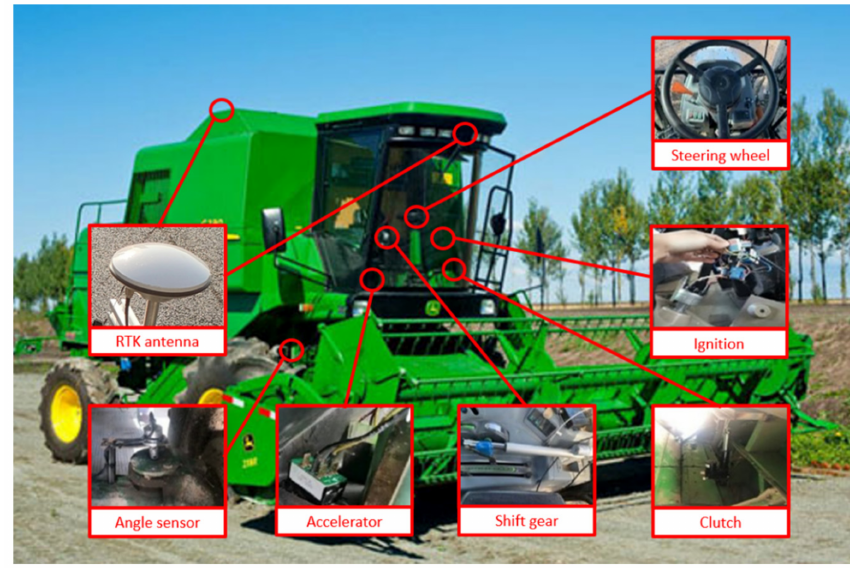
Figure 14. Reconstruction of the electric control system for the combine